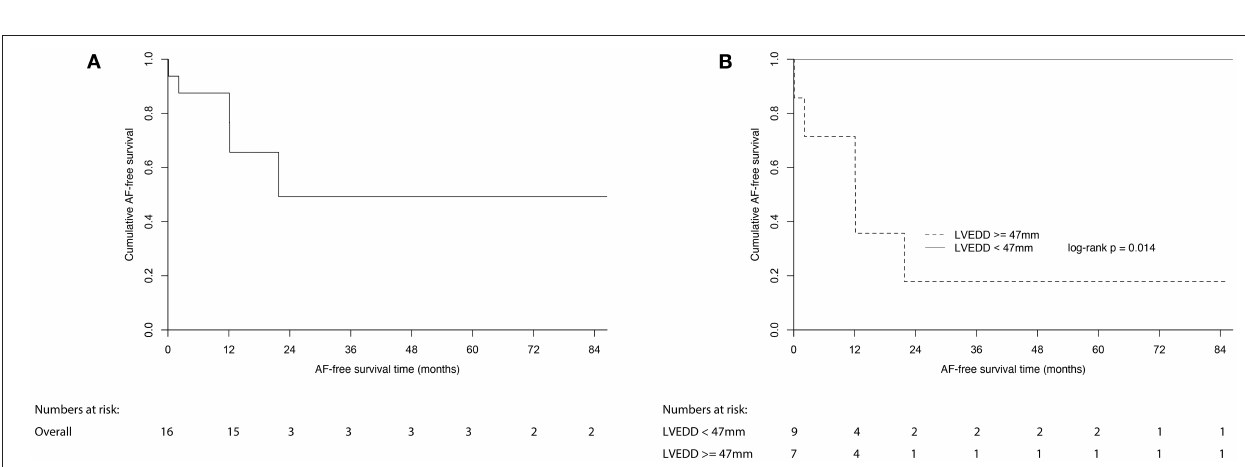
with or without an abnormal ECG indicating arrhythmia at